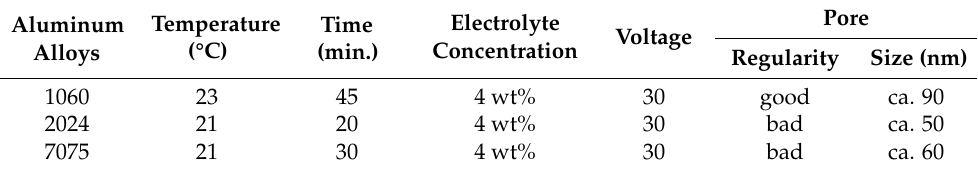
Table 2. Optimized anodization parameters of the 1060, 2024 and 7075 aluminum alloys.